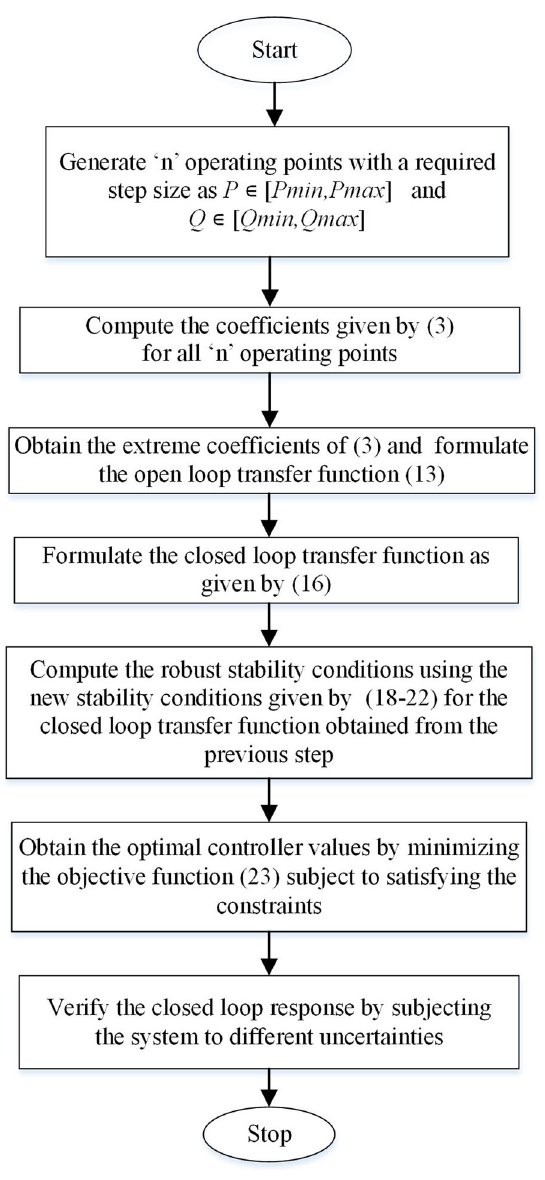
operating conditions Fig. 5 Flow chart for the proposed robust PID-PSS